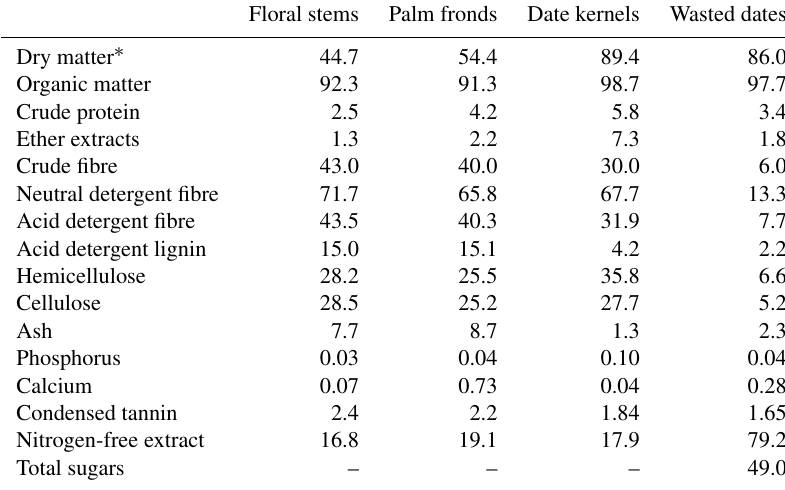
Table 1. Dry matter (%) and chemical composition (% DM) of date palm by-products.